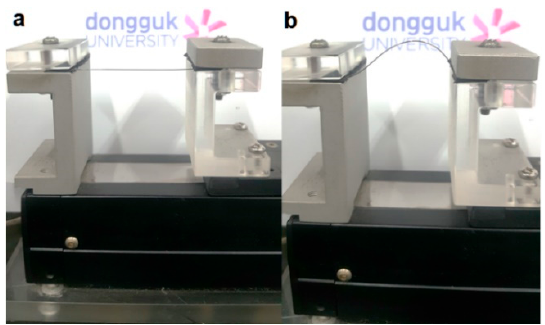
Figure 1. Photographic image of ZnO/V 2 O 5 deposited PET single fiber ( a ) at straight and ( b ) full- bending conditions. fullbending